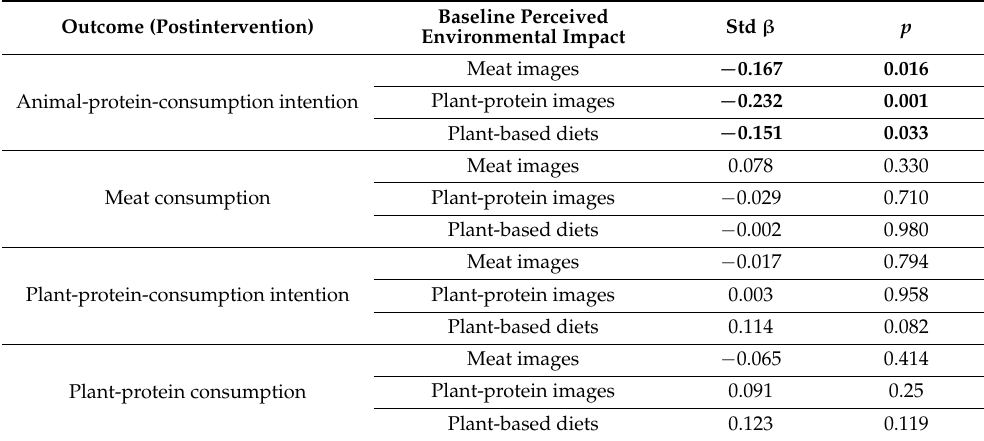
Table 3. Influence of baseline perceived environmental impact on changes in consumption intention and behavior.